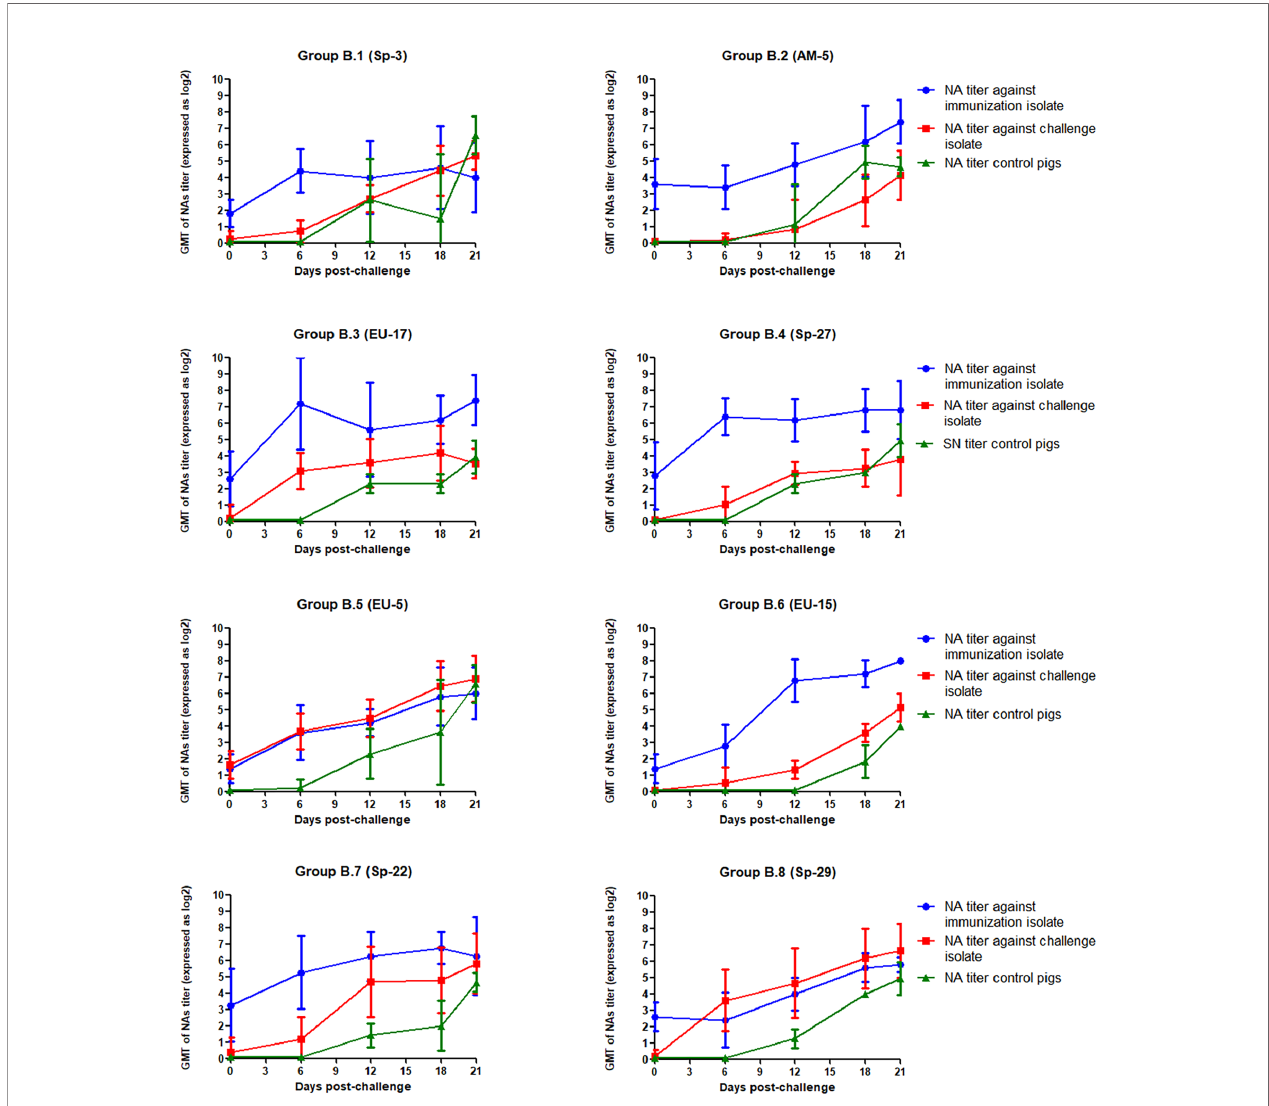
FIGURE 4 | GMT of NAs against the immunization and challenge PRRSV isolates in immunized pigs and against challenge PRRSV isolate in control pigs in the eight groups included in the study from the day of challenge to the end of the experiment in experiment B. The graph illustrates the GMT ± standard